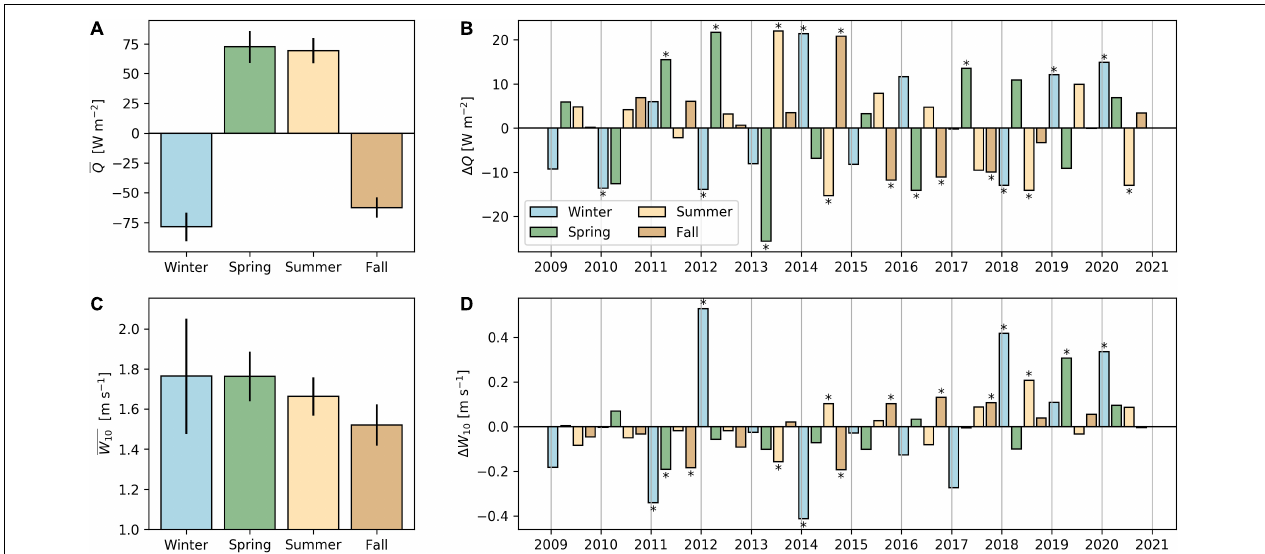
FIGURE 2 | Average (+/– one standard deviation) seasonal net surface heat fluxes (A) and wind speed (C) during the sampling period 2009–2020, and seasonal anomalies with respect to the long-term seasonal average (B,D) . In panels (B,D) , seasonal anomalies greater/smaller than +/– one standard deviation of the long-term average are marked with an asterisk (*). Seasons are defined as winter (DJF), spring (MAM), summer (JJA), and fall (SON). Positive heat flux means a net heat gain by the